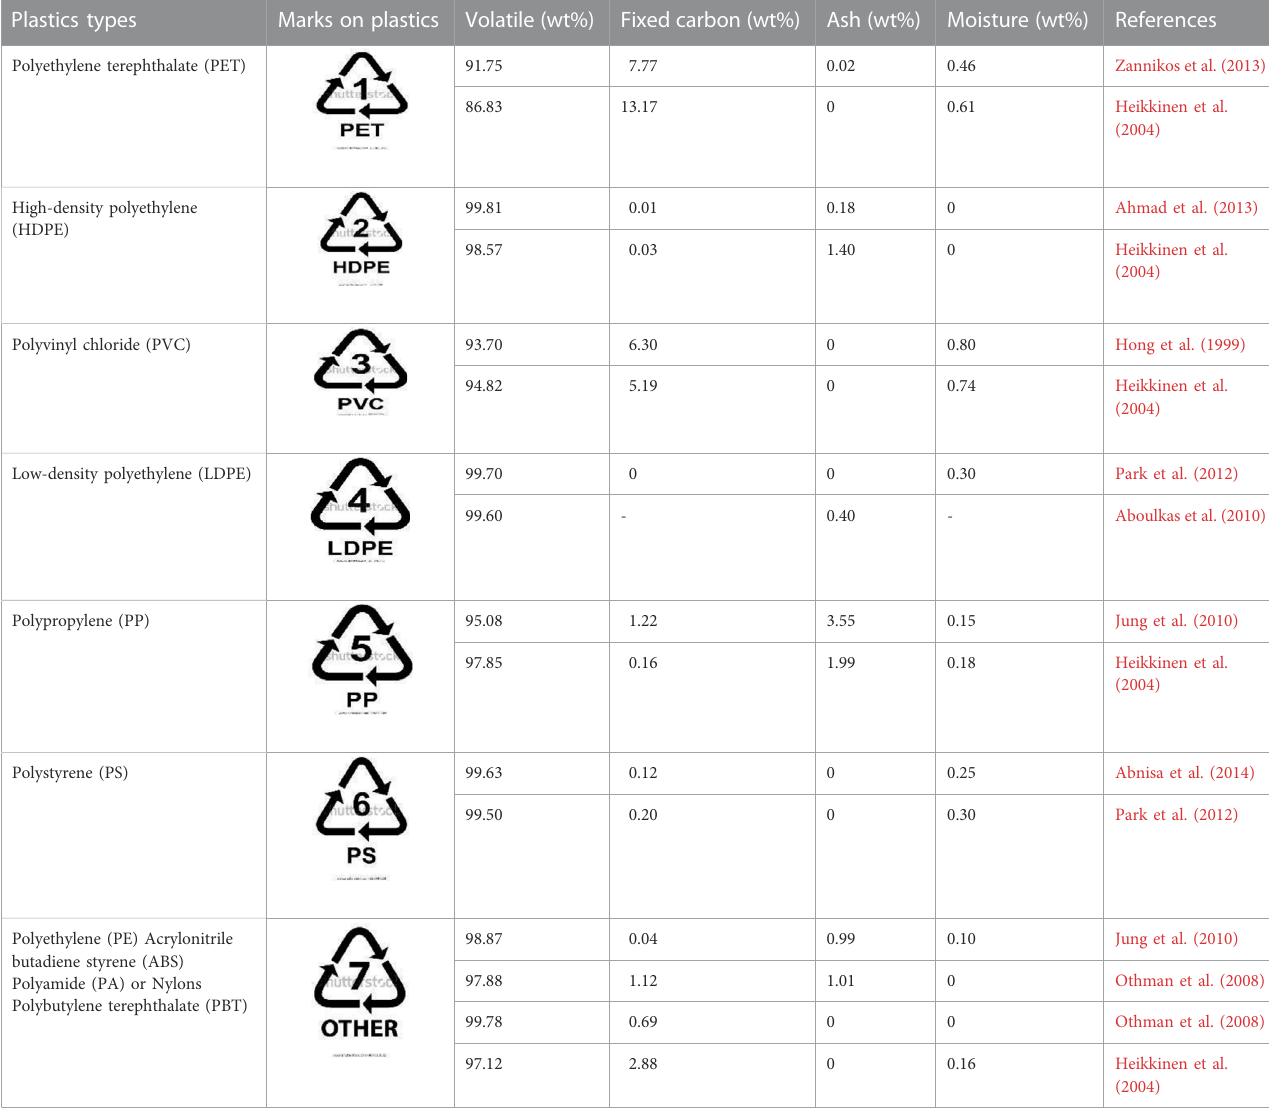
TABLE 5 Proximate analysis of plastics (Abnisa and Wan Daud, 2014). Plastics types